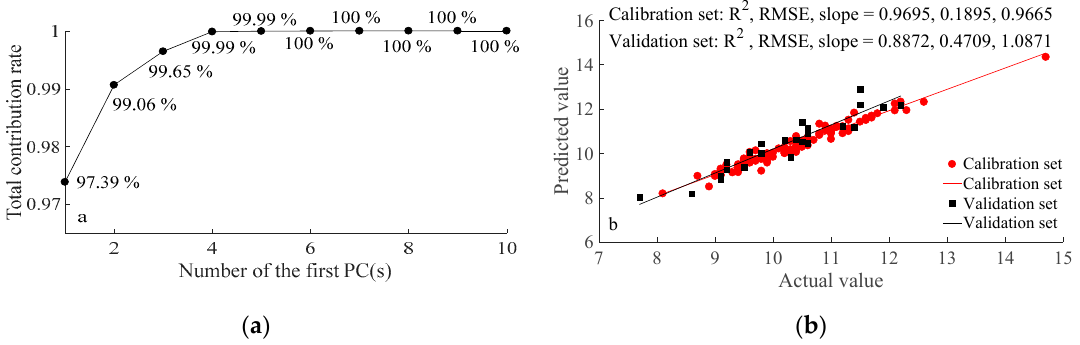
Figure 9. Principal component analysis (PCA)-BPNN detection results of TSS based on E-nose with combined feature extraction method. ( a ): the contribution rate distribution of principal component (PC); ( b ) BPNN detection results.